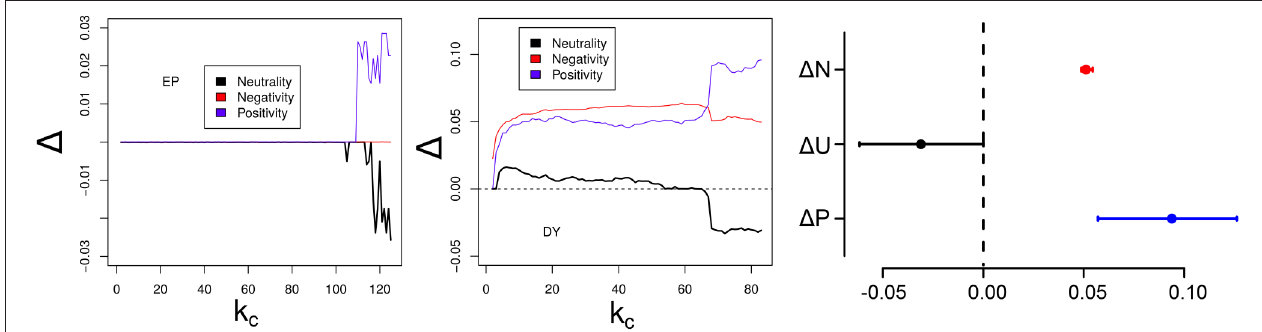
FIGURE 11 | Wilcoxon distances for averaged user emotions between divisions in core and periphery, depending on the division value k c , for EP on the left and DY on the center. Right: Wilcoxon distances between inner and outer parts of